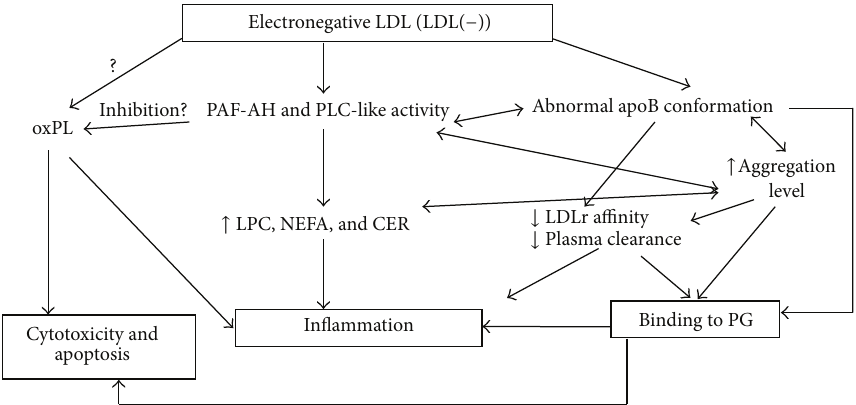
Figure 1: Putative relationships between the physicochemical properties of LDL( − ) and its inflammatory actions. Phospholipolytic activities contained in LDL( − ) increase its LPC, NEFA, and CER content. These compounds are involved in the inflammatory action of the particle. Phospholipolytic activities could also be related to the abnormal apoB conformation and high aggregation of LDL( − ), which may contribute to its decreased plasma clearance and increased binding to PGs. The retention of LDL( − ) to endothelium by PG would favor the inflammatory action of LDL( − ) on the arterial wall cells. Some authors have suggested that the presence of oxPL in LDL( − ) is responsible for the inflammatory, cytotoxic, and apoptotic effects of this particle. LDL( − ): electronegative LDL, oxPL: oxidized phospholipids, PAF-AH: platelet- activatingfactoracetylhydrolase,PLC:phospholipaseC,LPC:lysophosphatidylcholine,NEFA:nonesterifiedfattyacids,CER:ceramide,apoB: apolipoprotein B, LDLr: LDL receptor, PG: